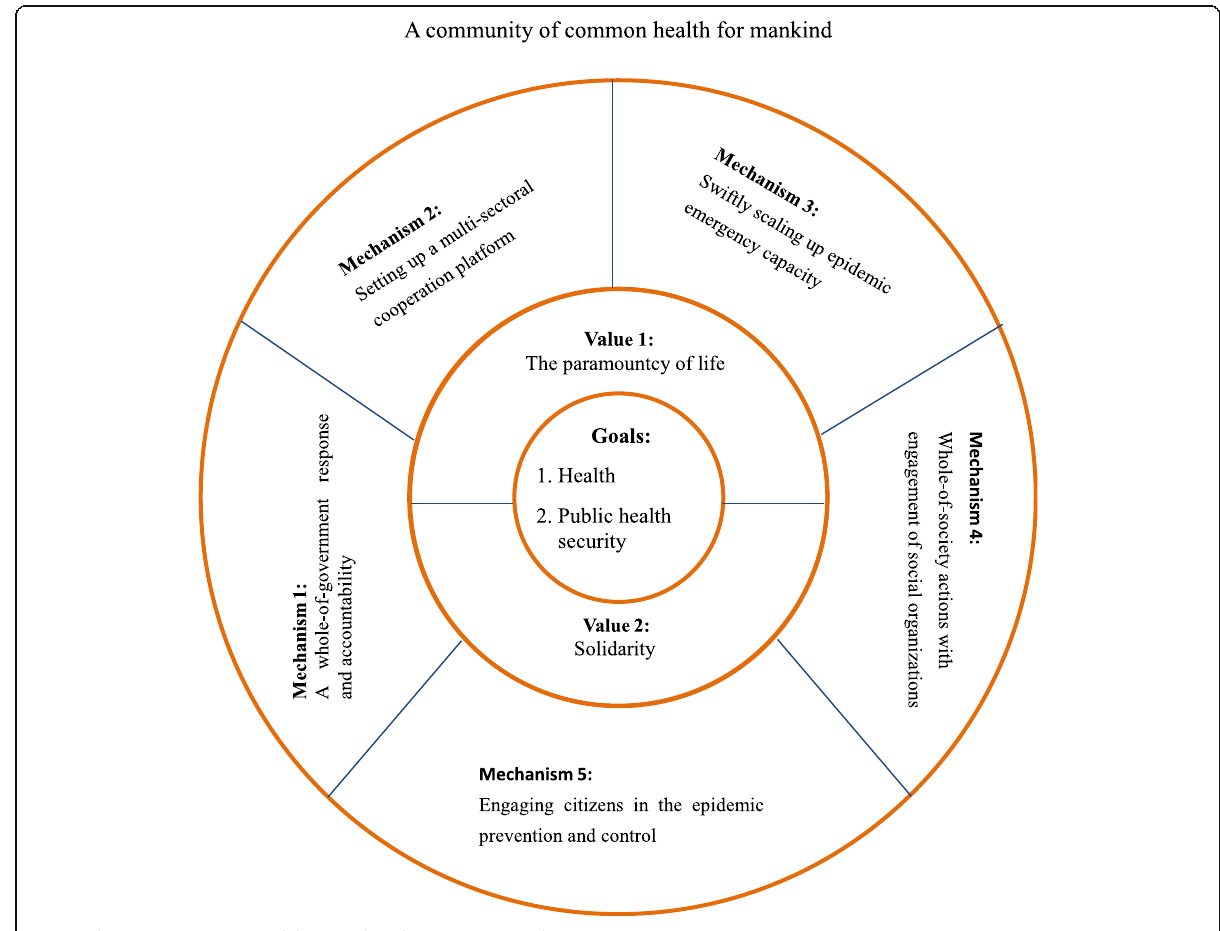
Fig. 1 China's governance model to combat the COVID-19